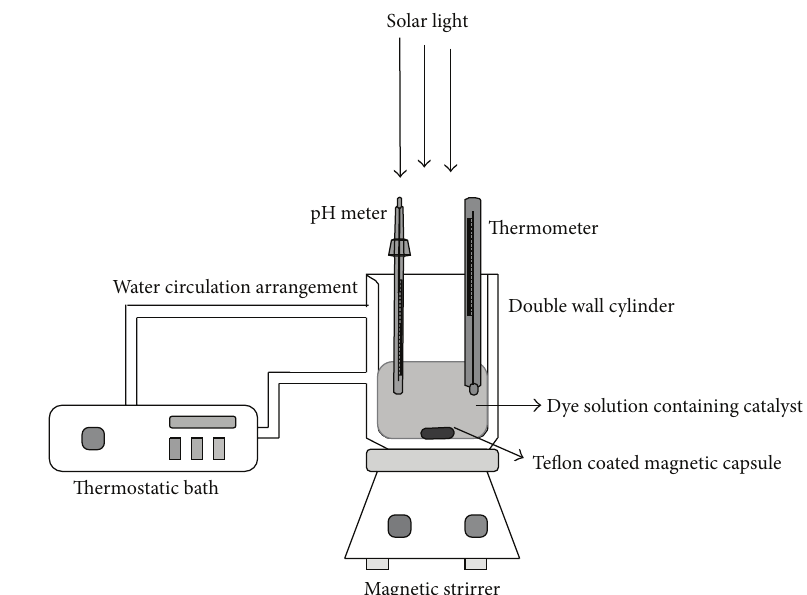
Figure 1: Schematic diagram of photoreactor.